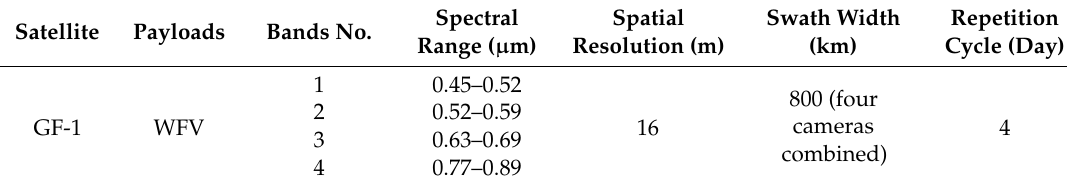
Table 1. Technical specifications of the GF-1 WFV